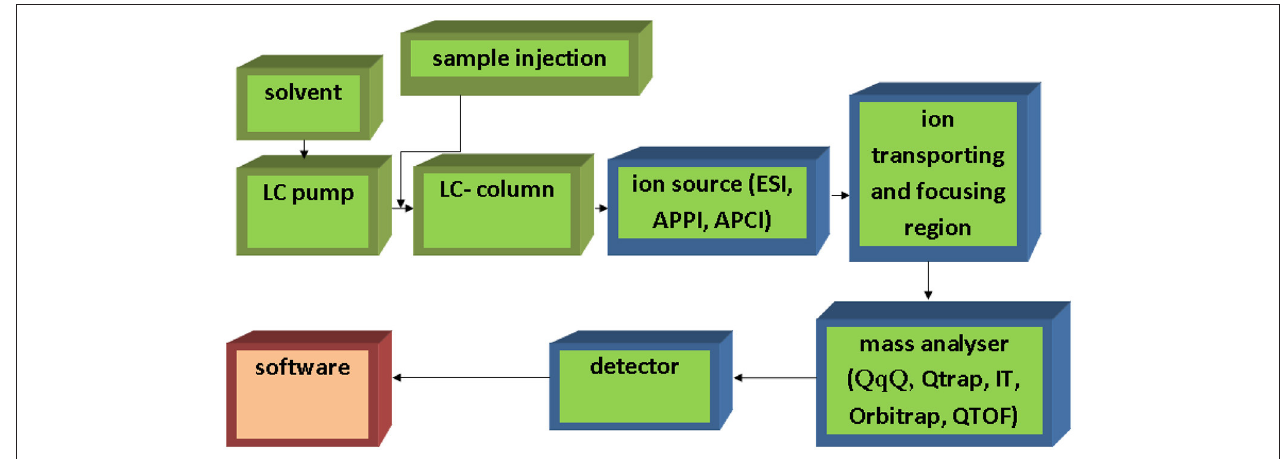
FIGURE 2 | Simple schematic of LC-MS